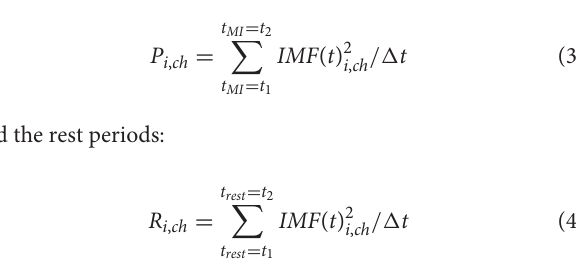
and electrode ( ch ) based on the power of the signal during